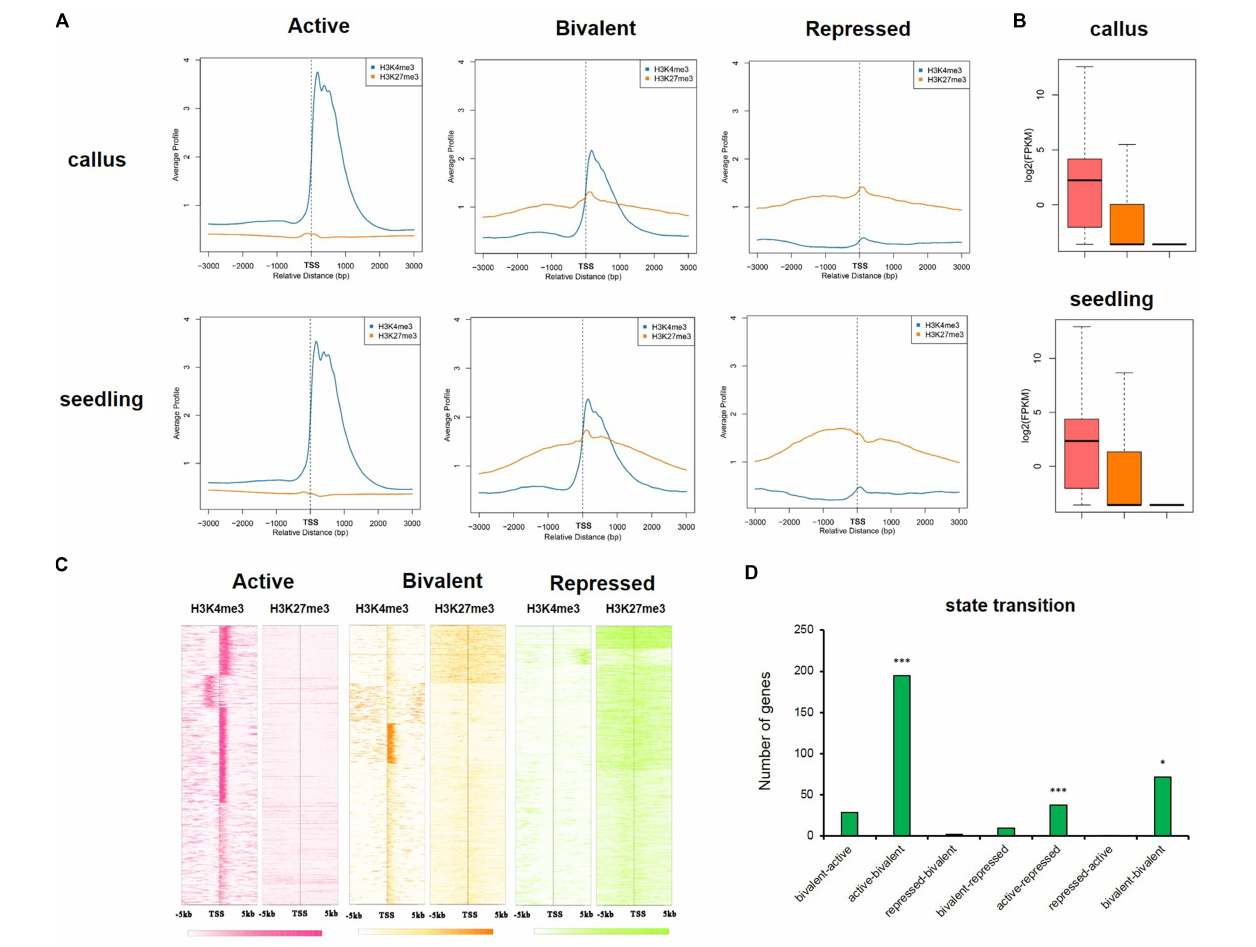
FIGURE 7 | The active, bivalent, and repressed states in callus and seedling. (A) The average gene profiles of H3K4me3 and H3K27me3 around TSS (from upstream 3 kb to downstream 3 kb) in the “active,” “bivalent,” and “repressed” states. (B) The gene expression profiles of the genes under the three states mentioned in (A) . (C) The H3K4me3 and H3K27me3 signals around TSS (upstream 5 kb and downstream 5 kb) of the genes in the three aforementioned states in the callus. (D) The 7 state transitions of genes preferentially expressed in the callus: “bivalent-active,” genes that are in the bivalent state in the callus, but in the active state in the seedling; “active-bivalent,” genes that are in the active state in the callus, but in the bivalent state in the seedling; “repressed-bivalent,” “bivalent-repressed,” “active-repressed,” “repressed-active,” and “bivalent-bivalent” are the same as defined above. The significance was evaluated by hypergeometric distribution (* P < 0.01, *** P <